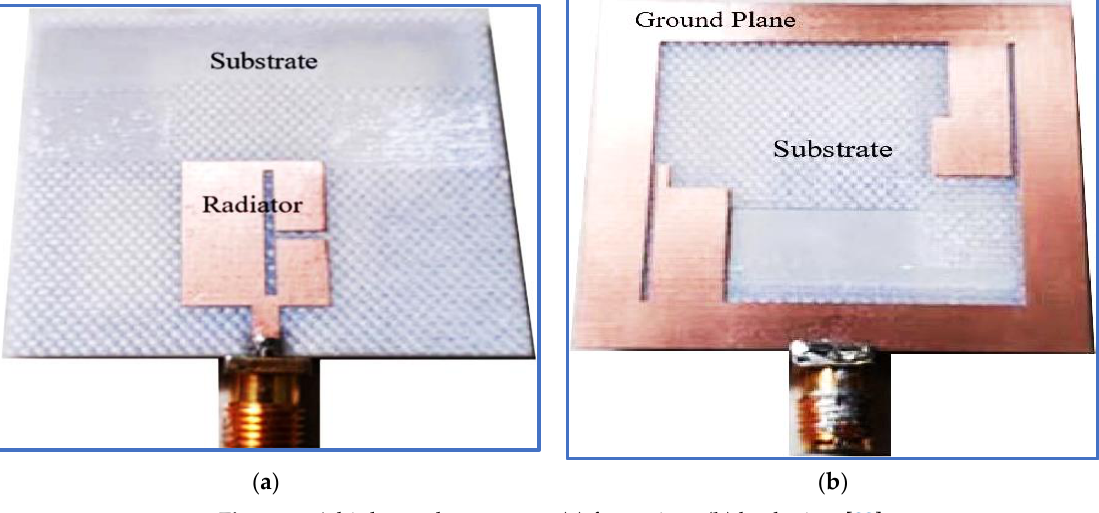
Figure 8. A biplanar slot antenna: ( a ) front view; ( b ) back view [82]. Nosrati and Tavassolian [85] proposed a biplanar slot antenna with a U-shaped feed line to produce the first impedance response. The IBW was improved, and circular polar- isation was generated by connecting half of a Y-shaped strip to a square slot ground (back side) whilst the remaining half of the Y-shaped strip and a small horizontal stub were